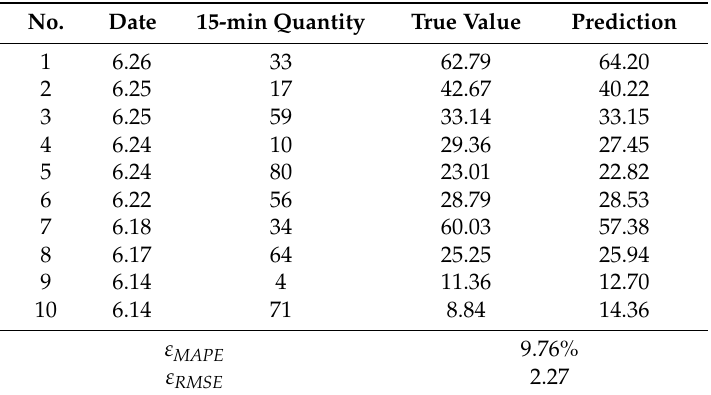
Table 2. Prediction data of single charging station every 15